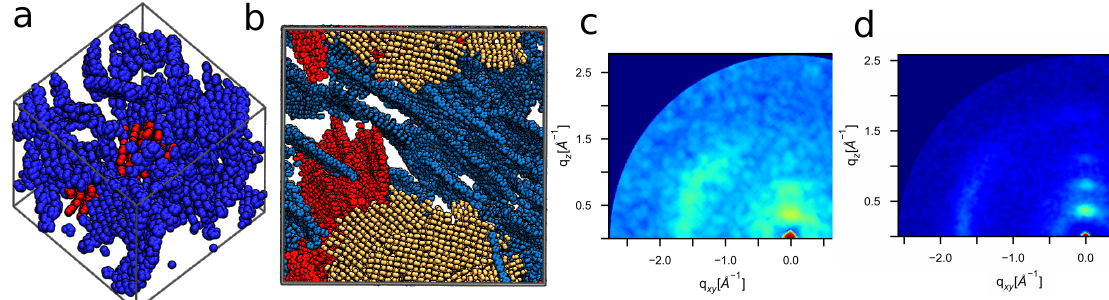
Figure 5. While small systems ( a ) are sufficient for identifying key structural features of ordered P3HT, large volumes ( b ) are needed to resolve structural periodicities (( c )-small, ( d )-large) and therefore enable experimental validation.